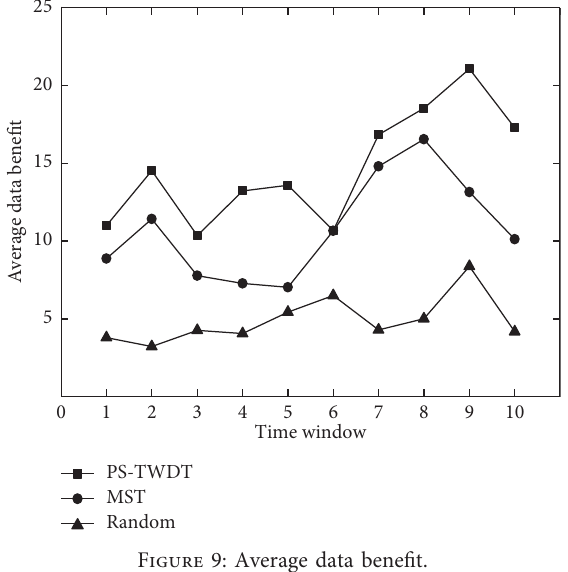
Figure 7: Average data